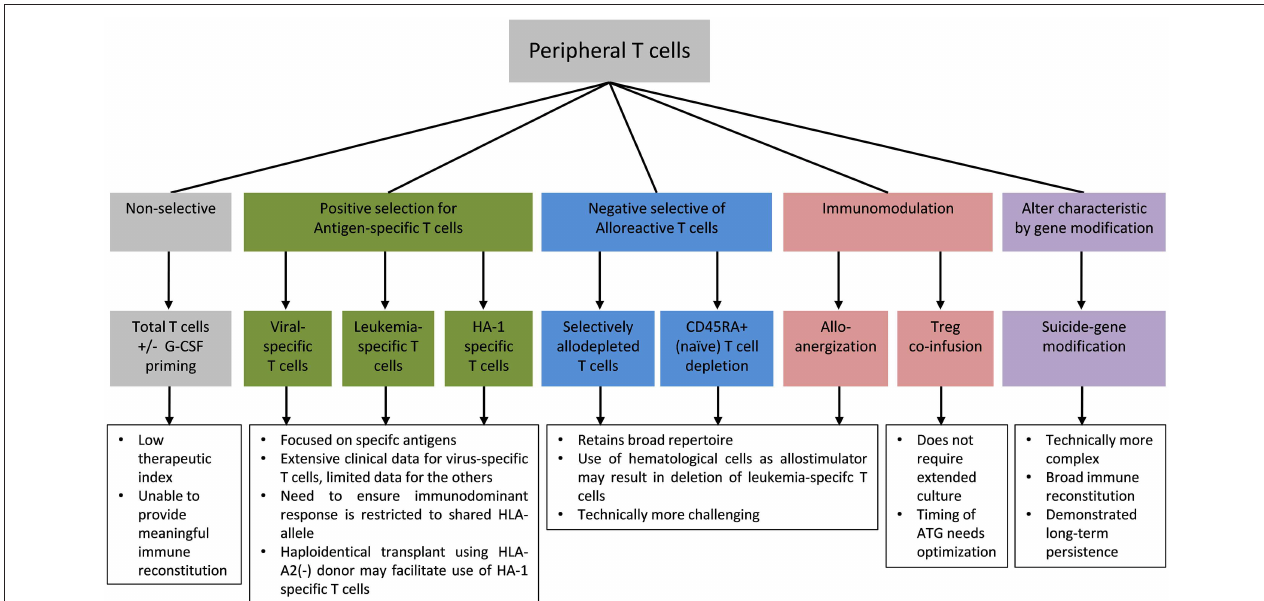
FIGURE 1 | Strategies for adoptive T cell